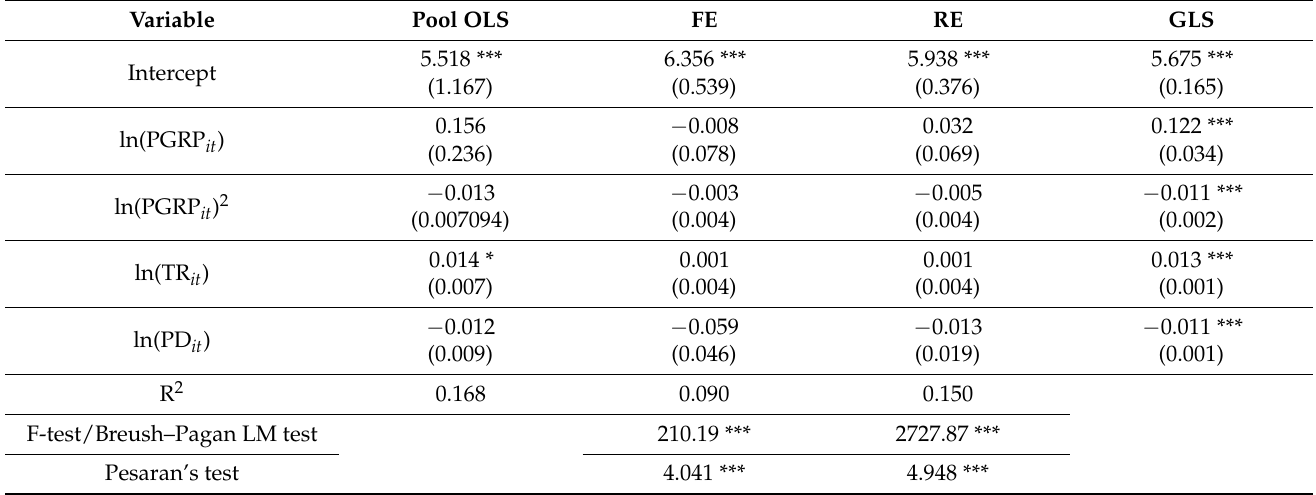
Table 2. Estimation Results of Global